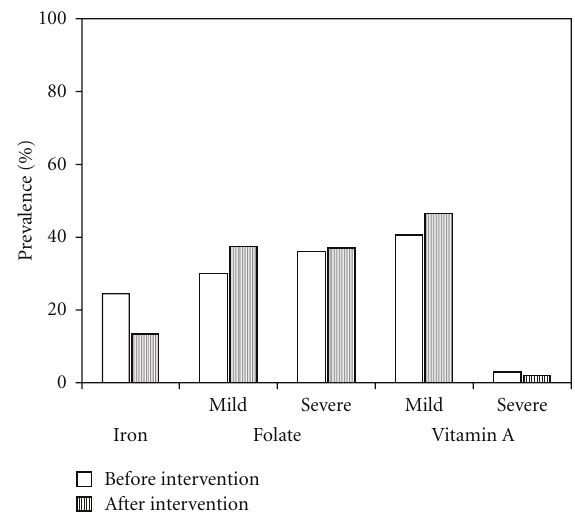
Figure 1: Prevalence of iron, folate, and vitamin A deficiencies in children, before and after the intervention of nutritional education in schools from Aragua, T´achira, and Lara States, Venezuela. ( n =